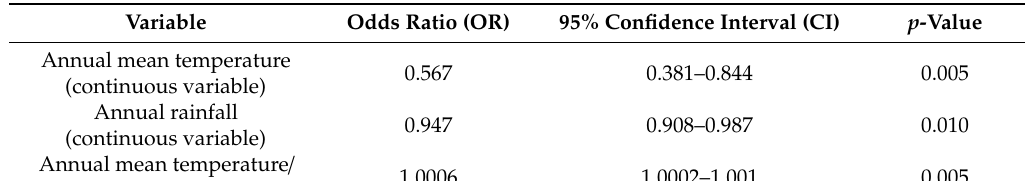
Table 4. Risk factors associated with higher Neospora caninum prevalence in sheep farms using multivariate multilevel modeling.